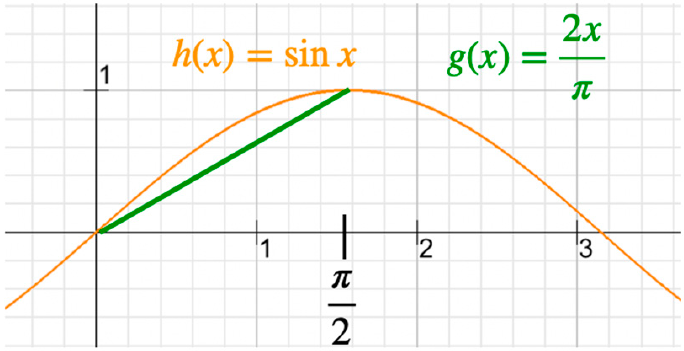
25 Figure 17. The length of a secant is smaller than the arc of the corresponding unit circle. The length of the arc determined by the angle 𝜑 on a circle of radius r is 𝑟𝜑 , i.e., if the circle is a unit circle, the length of the arc (green in the Figure) is 𝜑 . A secant of the unit circle (red in the Figure 17) can be defined by the two complex numbers on the unit circle (black in the Figure 17) that are the endpoints of the secant. Thus, the length of this secant is the difference of these complex numbers. One of these points can always be 1 because a corresponding rotation is length-preserving; the other point is then 𝑒 𝑖𝜑 , where 𝜑 is the angle of the arc cut by the secant. The length of this secant is then (cid:3627)1 − 𝑒 (cid:3036)(cid:3101) (cid:3627) . This proves the inequality (cid:3627)1 − 𝑒 (cid:3036)(cid:3101) (cid:3627) ≤ |𝜑| . □ ((cid:3048)(cid:3043)(cid:3043)(cid:3032)(cid:3045)(cid:3029)(cid:3042)(cid:3048)(cid:3041)(cid:3031)) Next, we compute |1 − 𝑒 (cid:3036)(cid:3101) | = ((cid:3002)) |1 − 𝑐𝑜𝑠𝜑 − 𝑖𝑠𝑖𝑛𝜑| = ((cid:3003)) (cid:3493)(1 − 𝑐𝑜𝑠𝜑) (cid:2870) + 𝑠𝑖𝑛 (cid:2870) 𝜑 = (cid:3493)1 − 2𝑐𝑜𝑠𝜑 + 𝑐𝑜𝑠 (cid:2870) 𝜑 + 𝑠𝑖𝑛 (cid:2870) 𝜑 = (cid:3493)2 − 2𝑐𝑜𝑠𝜑 = √2(cid:3493)1 − 𝑐𝑜𝑠𝜑 = ((cid:3004)) √2(cid:3495)2𝑠𝑖𝑛 (cid:2870) 𝜑 2 = ((cid:3005)) 2𝑠𝑖𝑛 𝜑 2 where ( A ) uses Euler’s formula, ( B ) is the definition of the modulus of a complex number with 𝑅𝑒 = 1 − 𝑐𝑜𝑠 𝜑 and 𝐼𝑚 = −𝑠𝑖𝑛 𝜑 , ( C ) is the double-angle formula, and ( D ) as- sumes that 𝑠𝑖𝑛 (cid:3101) (cid:2870) ≥ 0 . To estimate a lower bound for 𝑠𝑖𝑛 (cid:3101) (cid:2870) , we analyze the function 𝑓(𝑥) = 𝑠𝑖𝑛 𝑥 − (cid:2870)(cid:3051) (cid:3095) . From elementary calculus, it is known that a function 𝜓 is concave on 𝐷 ⊆ ℝ if and only if its second derivative is not positive on D, i.e., 𝜓 ′′ ≤ 0 on D.